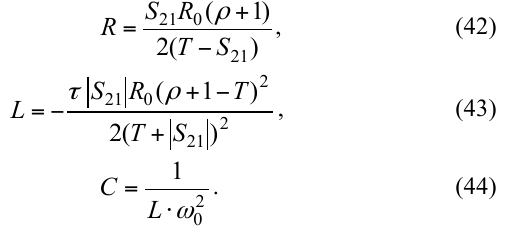
1.09 GHz to 1.26 GHz which can go down below -1.5